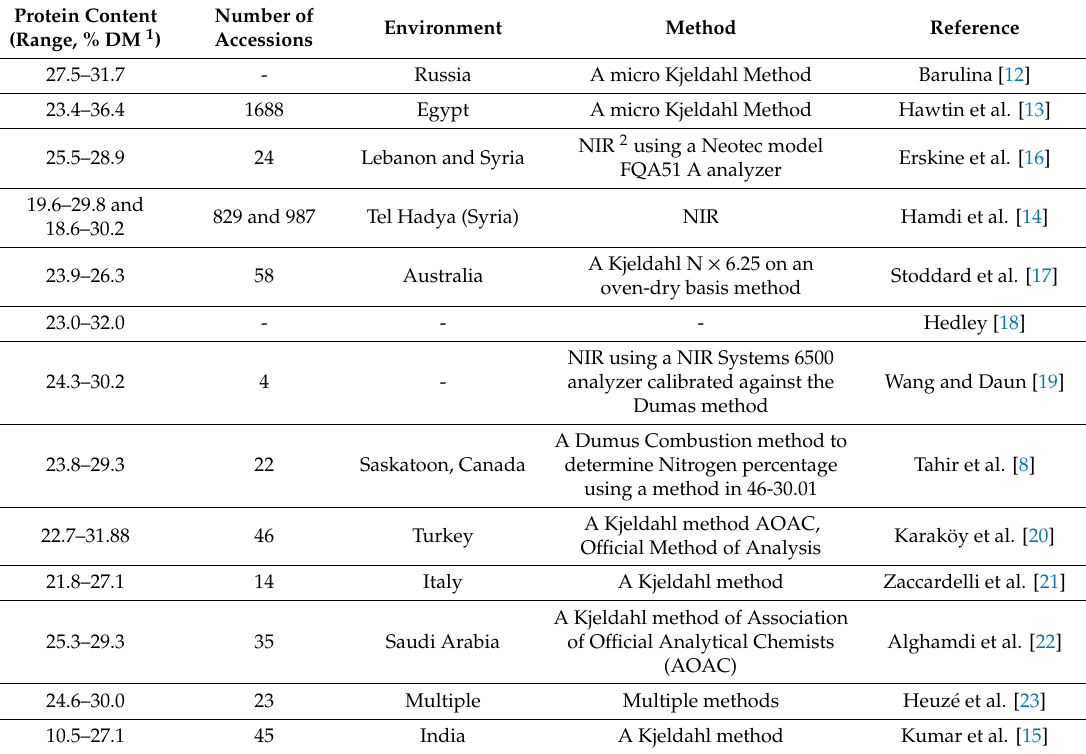
Table 2. Genetic variation and methods used measuring seed the crude protein content in cultivated lentil. Protein Content (Range, % DM 1